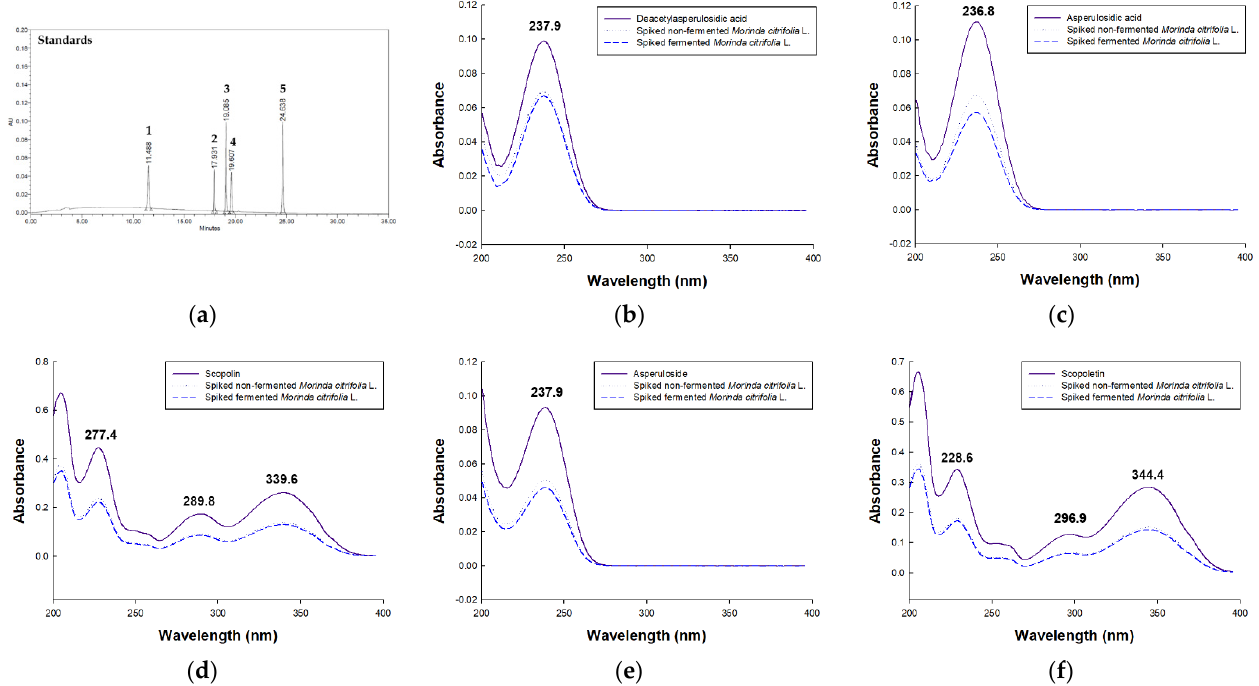
Figure 1. HPLC chromatographic of bioactive compounds marked with 1–5 represent deacetylasperulosidic acid, asperulosidic acid, scopolin, asperuloside and scopoletin ( a ). PDA spectrums of bioactive compounds in STD spiked non-fermented and fermented Morinda citrifolia L. extracts ( b – f ).